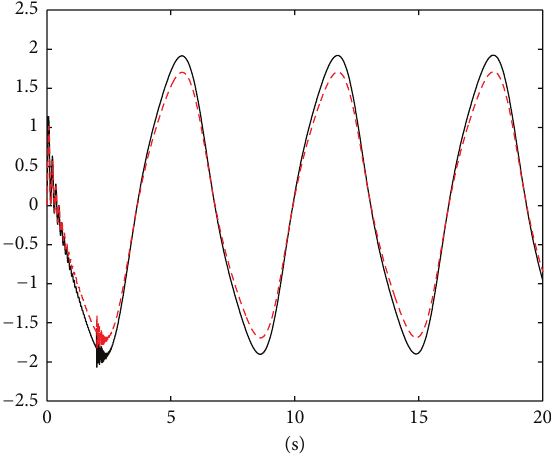
Figure 3: The curves of 𝑥 2 (solid) and its estimation ̂𝑥 2 (dash).